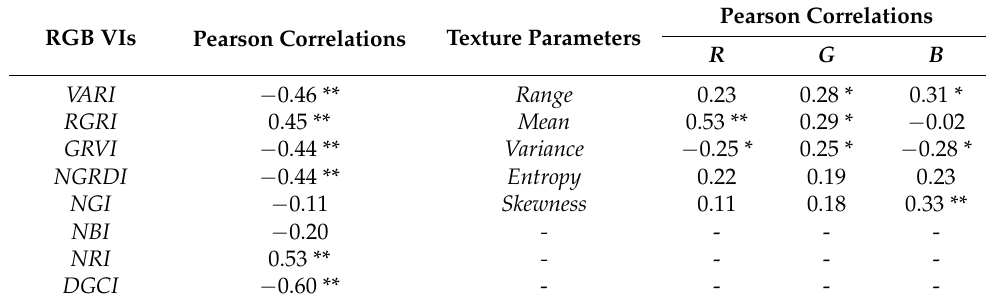
Table 6. Correlation between RGB VIs, texture parameters, and Anth of tree peony leaves. RGB